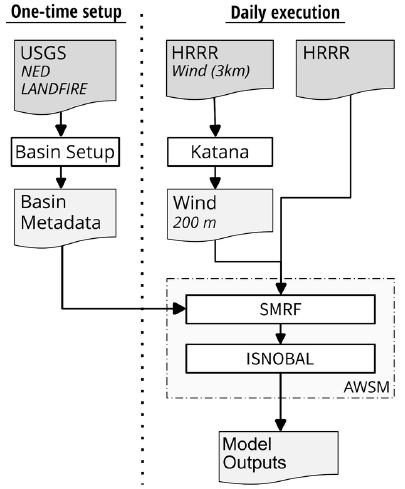
Figure 2. Overview of the iSnobal model architecture showing the one-time setup process and the daily execution